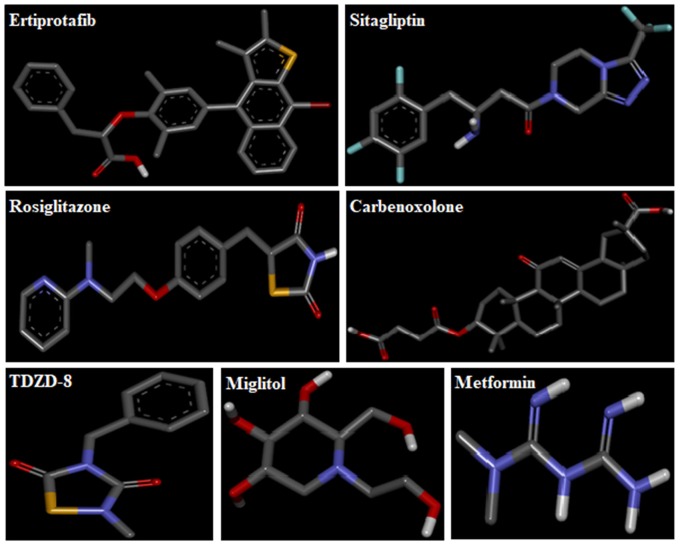
3D-structures of reference drugs: miglitol, metformin, carbenoxolone, thiadiazolidinone-8 (TDZD-8), rosiglitazone, sitagliptin and ertiprotafib, drawn through Chem. Sketch 2015 2.5 and saved in PDB format through Biovia Discovery Studio 2016. Atoms are shown by colors; gray color (carbon atoms), white color (hydrogen atoms), red color (oxygen atoms), blue color (nitrogen atoms), dark red (bromine), and yellow color (sulfur atoms).